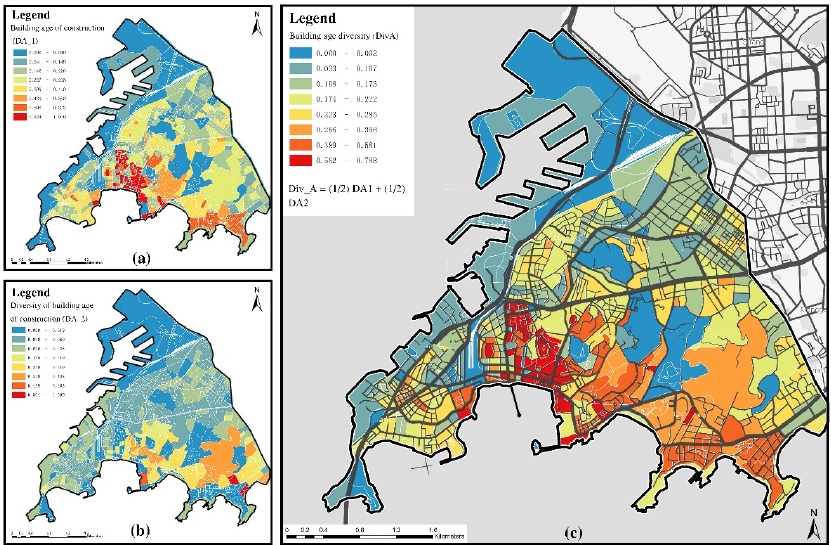
Figure 6. Building age diversity analysis. (a) Building construction age. (b) Building construction age diversity. (c) Building age diversity composite index. age diversity. ( c ) Building age diversity composite